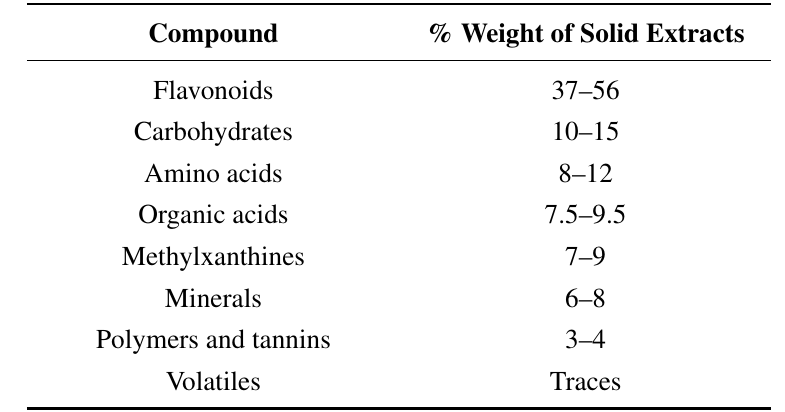
Table 1. Mean composition (% weight of solid extract) of green tea infusion determined by high performance liquid chromatography (HPLC).